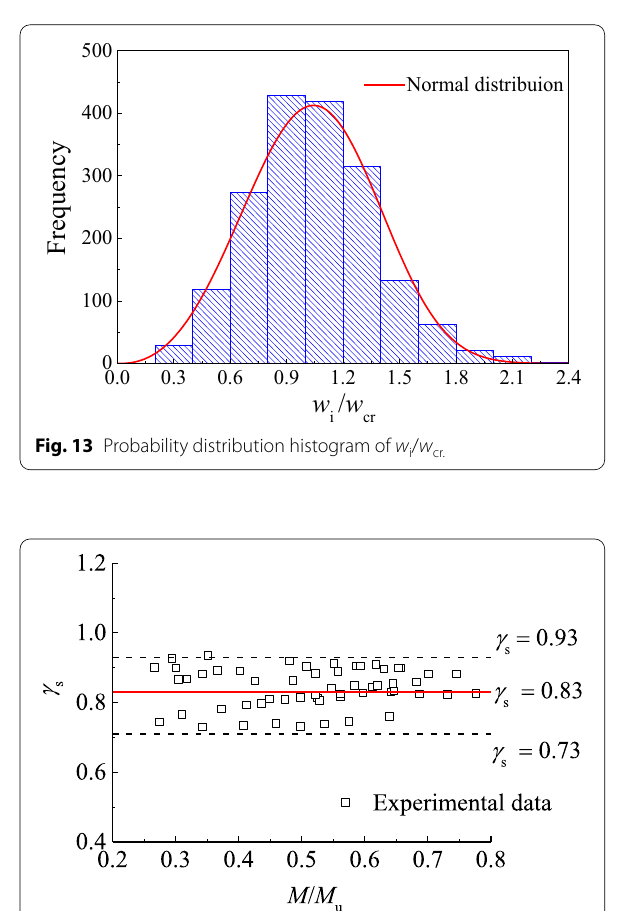
Fig. 14 Relationship between γ s and